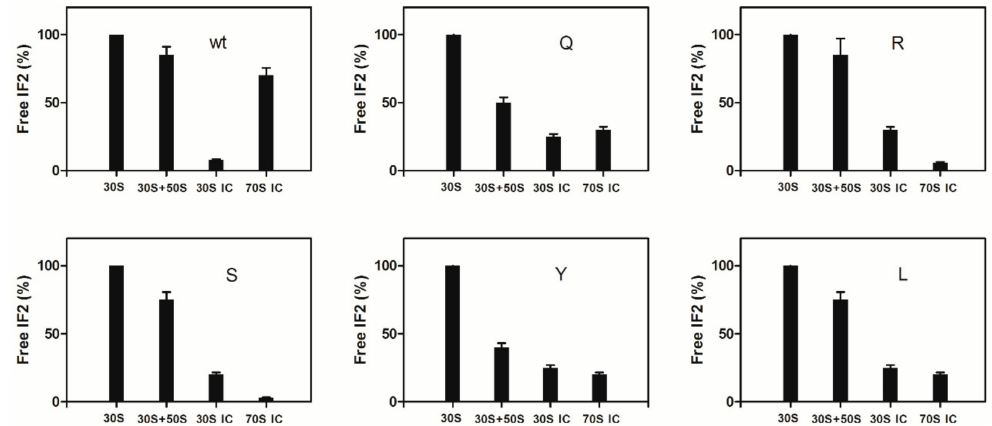
Figure 7. Failure of the IF2His301 mutants to dissociate from the ribosomes. The histogram bars represent the amount of free (i.e., not ribosome-bound) IF2 present in the post-ribosomal supernatant after ultracentrifugation. The experimental conditions are identical to those described for the experiment of Figure 6, but for the fact that all samples contained 1 mM GTP and di ff erent IF2His301 mutants as specified inside each panel. More experimental details are given in Materials and